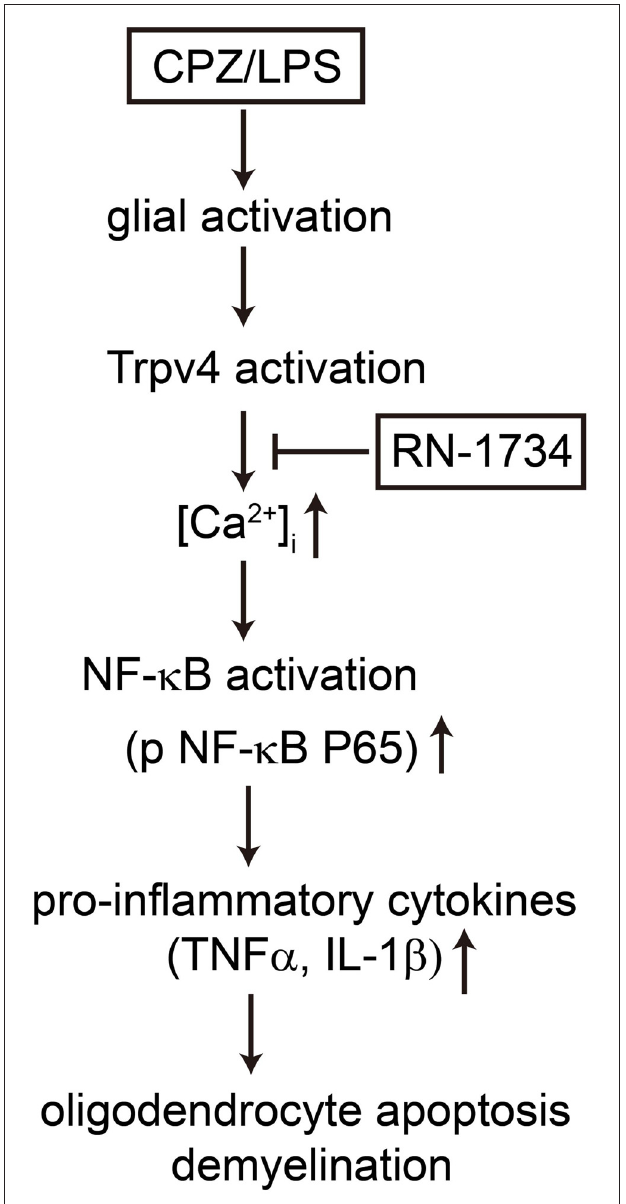
FIGURE 6 | Possible mechanisms by which TRPV4 activation caused oligodendrocyte apoptosis and demyelination. TRPV4 activation induced by CPZ or LPS increases Ca 2 + influx and glial activation, which promotes the release of TNF- α and IL-1 β by activating the NF- κ B signaling pathway. The production of proinflammatory cytokines results in oligodendrocyte apoptosis and demyelination. The TRPV4 inhibitor RN-1734 inhibits the NF- κ B signaling pathway, decreases the level of proinflammatory cytokines and rescues oligodendrocyte damage and demyelination.